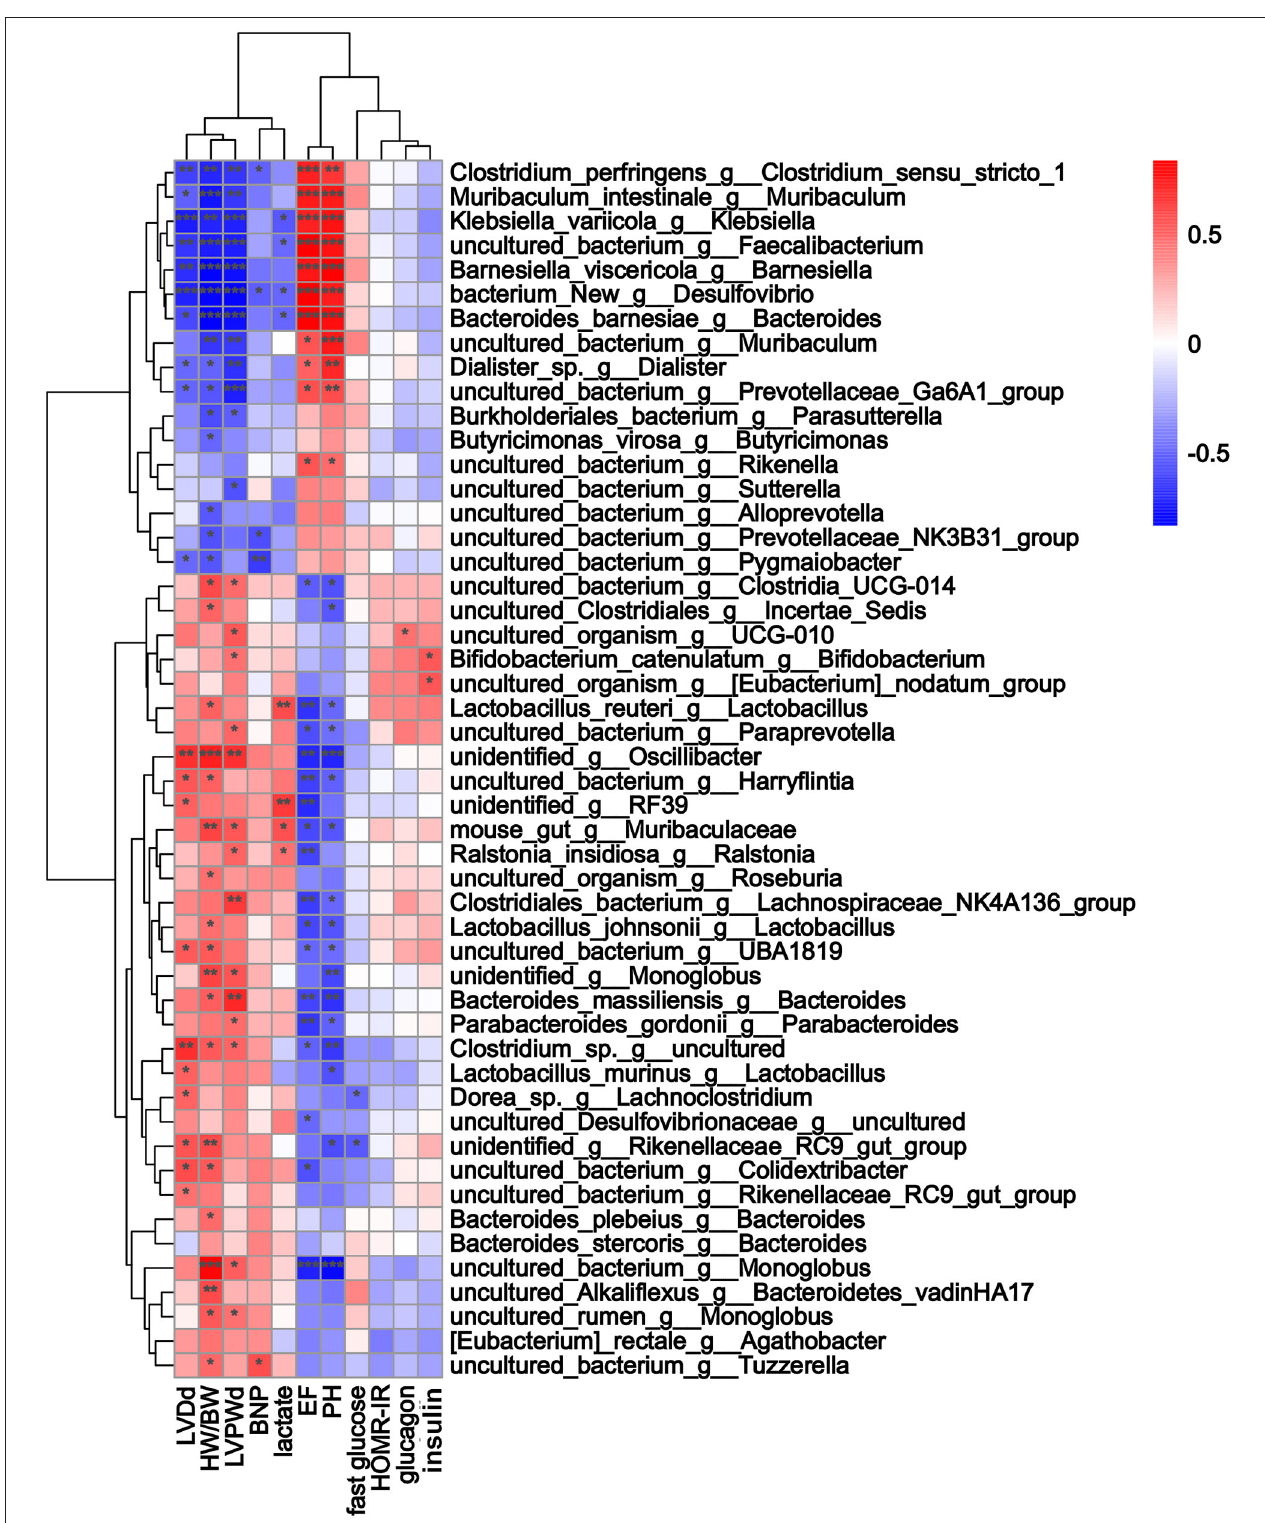
FIGURE 5 | The alterations in microbial species were associated with heart function parameters. Heatmap of Spearman’s correlations between changes in cardiac function, glucose levels, fecal indices, and microbiota alterations caused by thoracic aortic constriction (TAC). Red indicates a positive correlation, and blue indicates a negative correlation. * p < 0.05, ** p < 0.01, and *** p < 0.001.